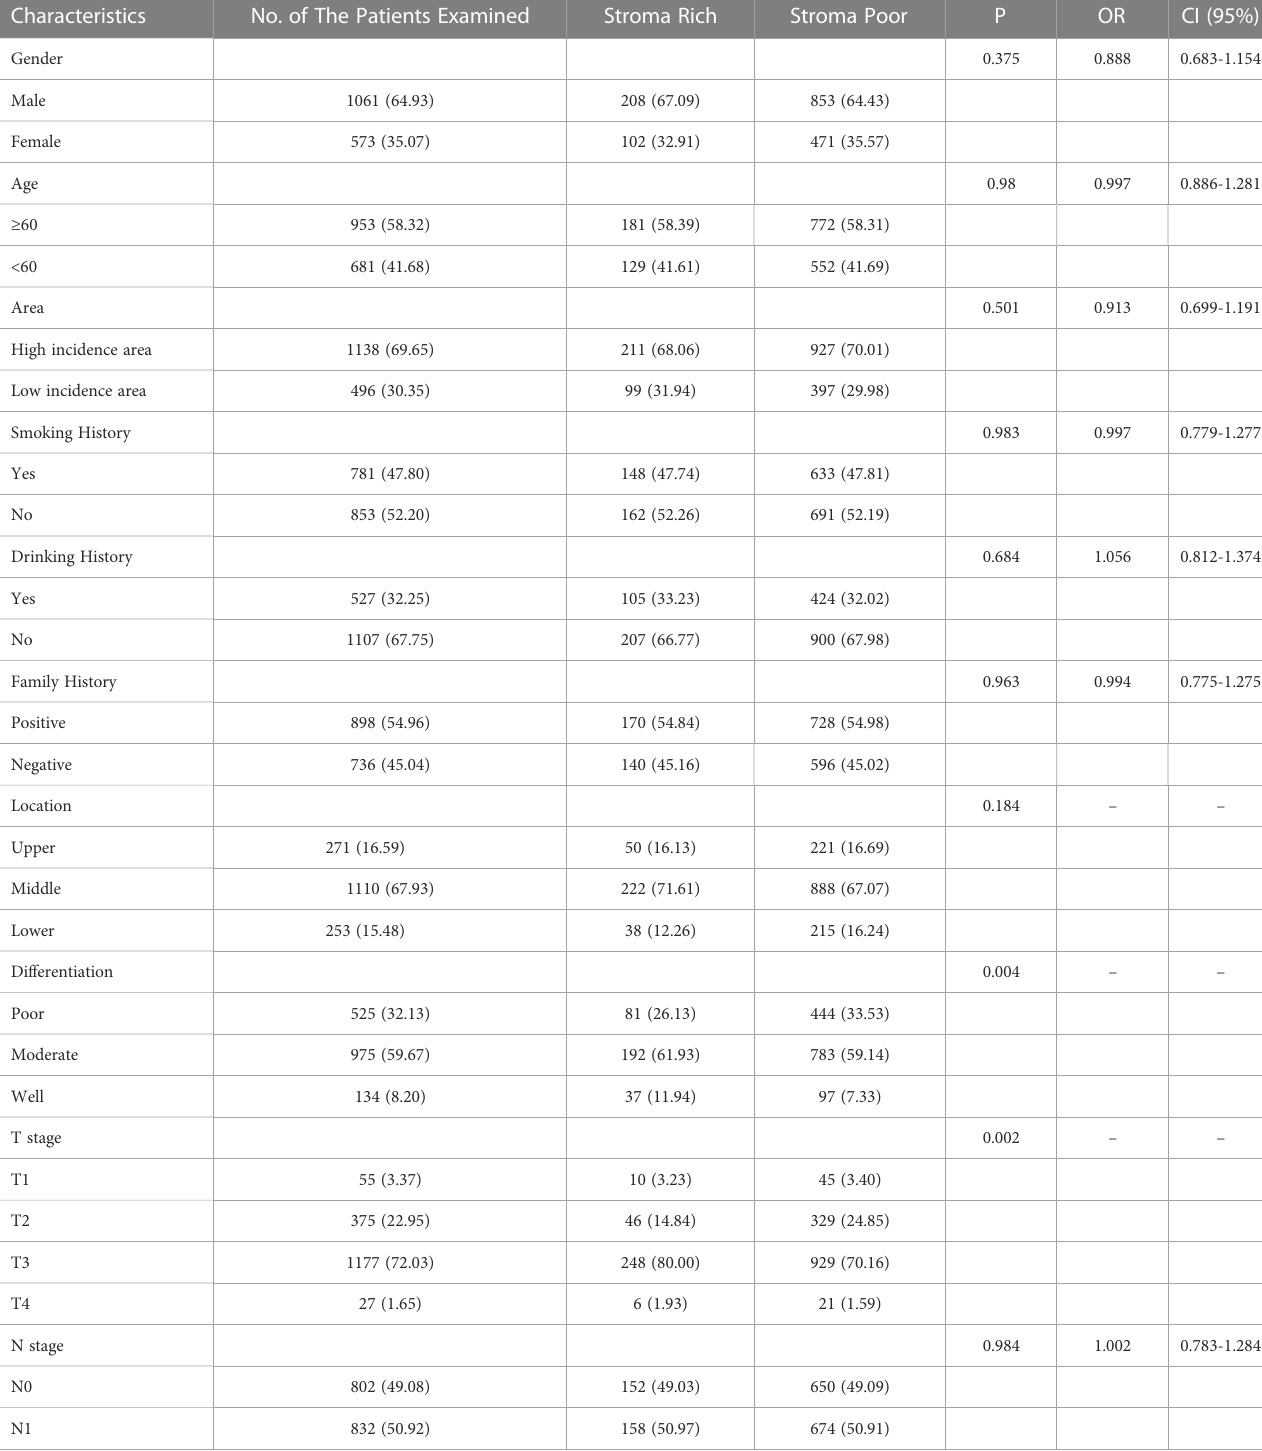
TABLE 2 Relationship between TSR and clinical characteristics, n